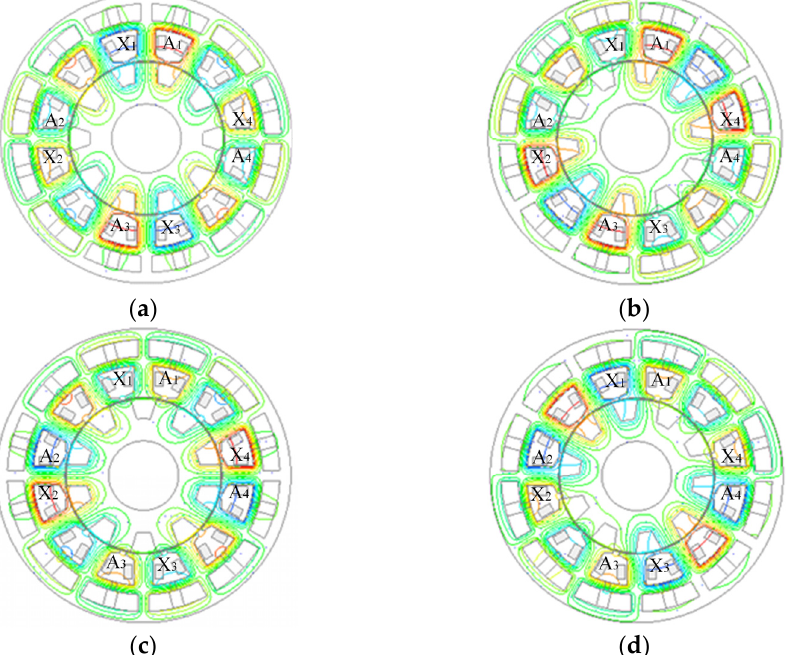
Figure 6. Distribution of magnetic flux lines at different rotor positions: ( a ) rotor at 0 electric angle; ( b ) rotor at 90 electric angle; ( c ) rotor at 180 electric angle; ( d ) rotor at 270 electric angle.